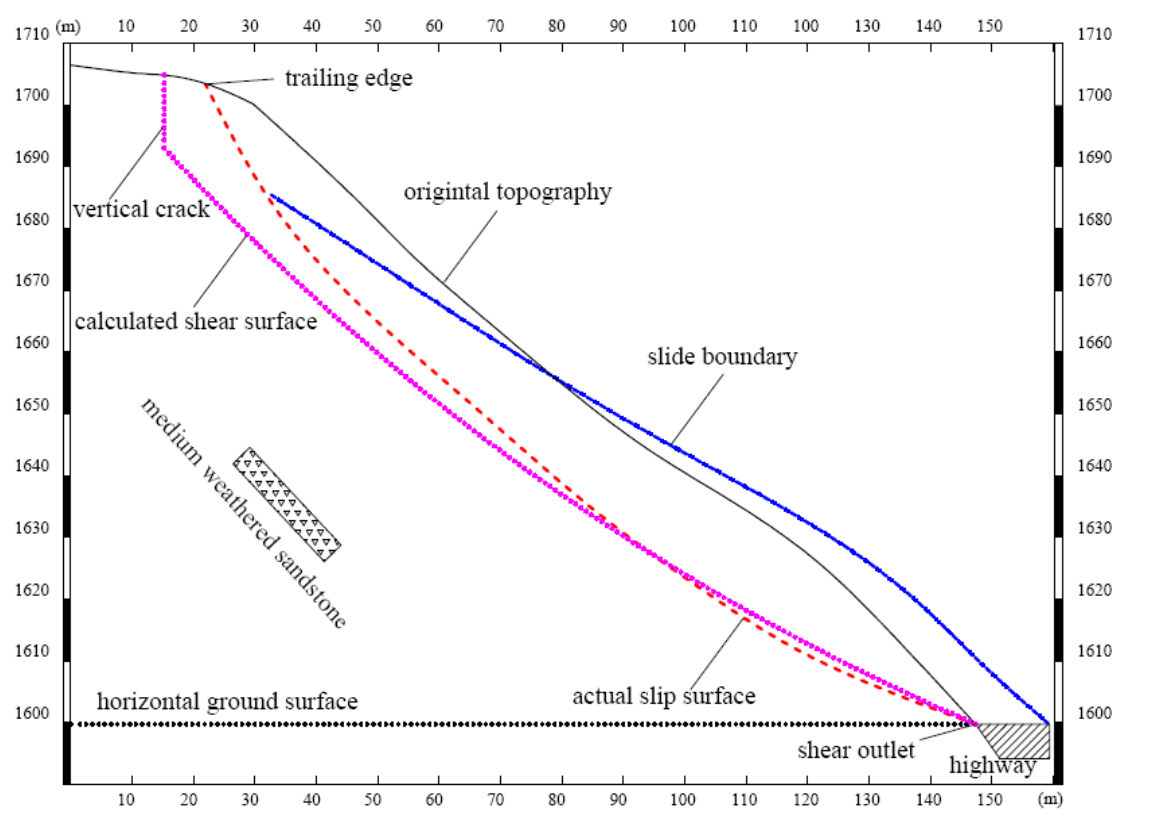
29 of 33 Figure 15. Morphology of highway landslide after collapse in Yunnan Province. According to the engineering geological exploration for the landslide, the mor- phology of slip body and actual failure surface are shown in Figure 16. Based on the above parameters, the minimum safety factor of the landslide is estimated at 0.98 by us- ing the specification method, and the investigation shows that the crack depth at the tailing edge of landslide is about 8.5m. Since the toe of slope is the outlet of shear slip surface, the toe circle failure model is selected first in this method. Then, through calcu- lation, the optimal crack depth is 11.3m, the horizontal distance from the slope crest is 13.5m, and the coordinate of the center of the circle is O ( −9 2.61,201.37). Finally, the failure surface can be seen in the purple dotted line in Figure 16, and the corresponding safety factor is 0.923. It is easily found that the results calculated by this study, which contains